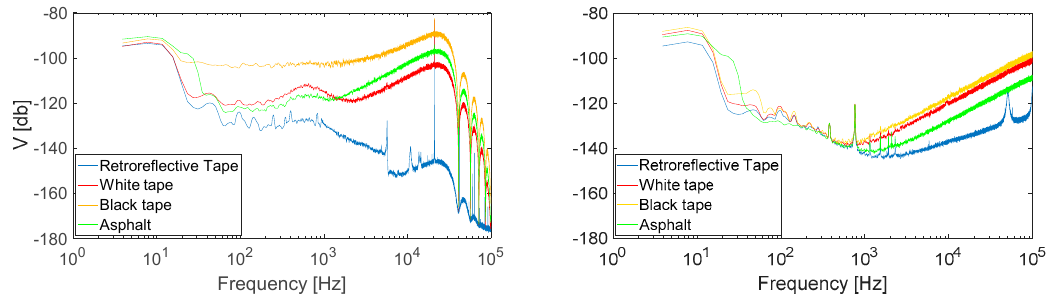
Figure 4. Noise floor measurement for four different surfaces by He–Ne SLDV ( left ) and infrared LDV ( right ). Stand-off distance is 1.7 m for asphalt and 9 m for all the other surfaces.